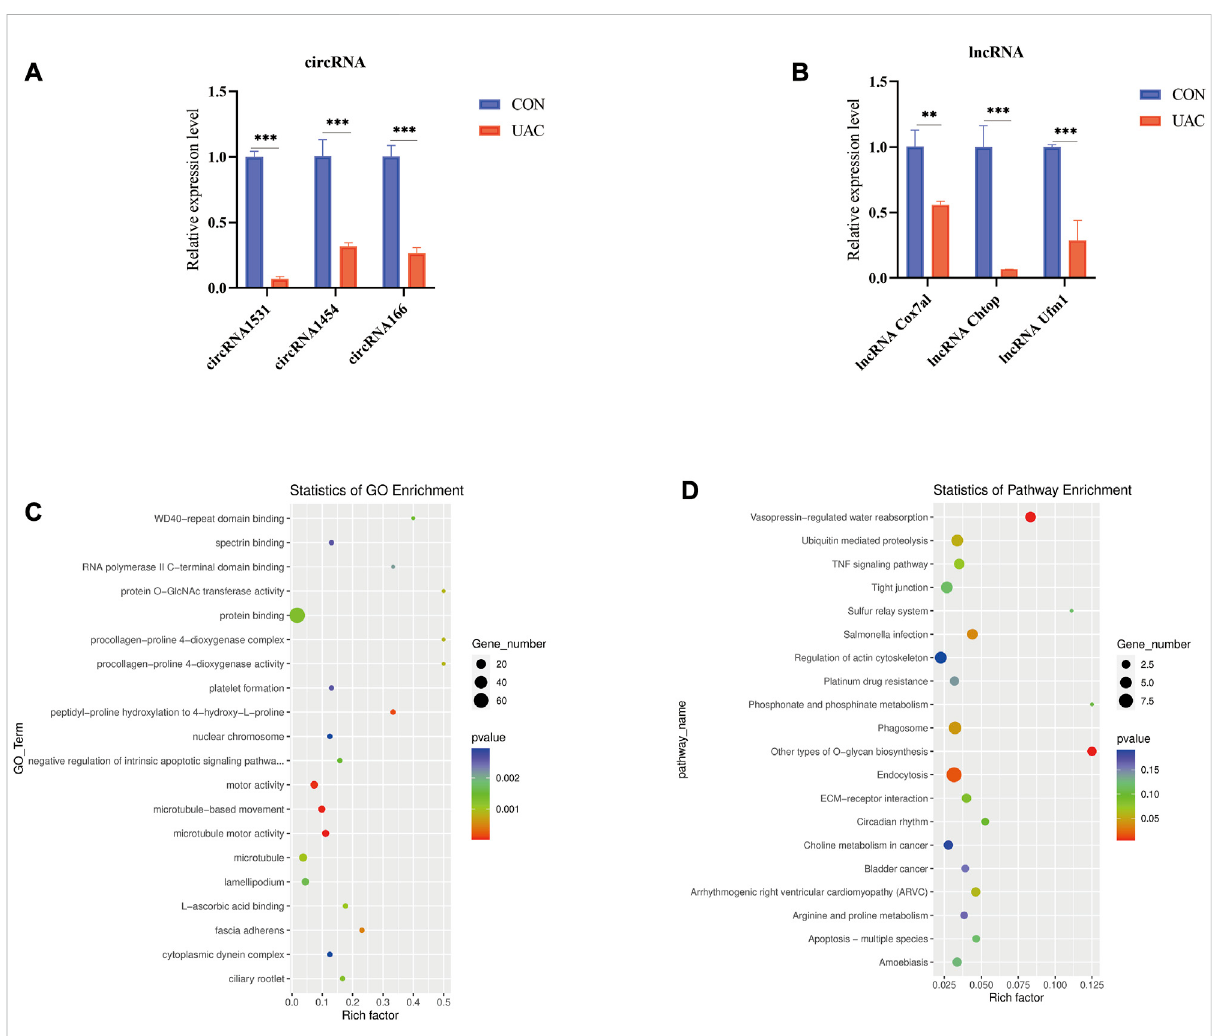
Wnt signaling pathway (Figure 5C). The KEGG